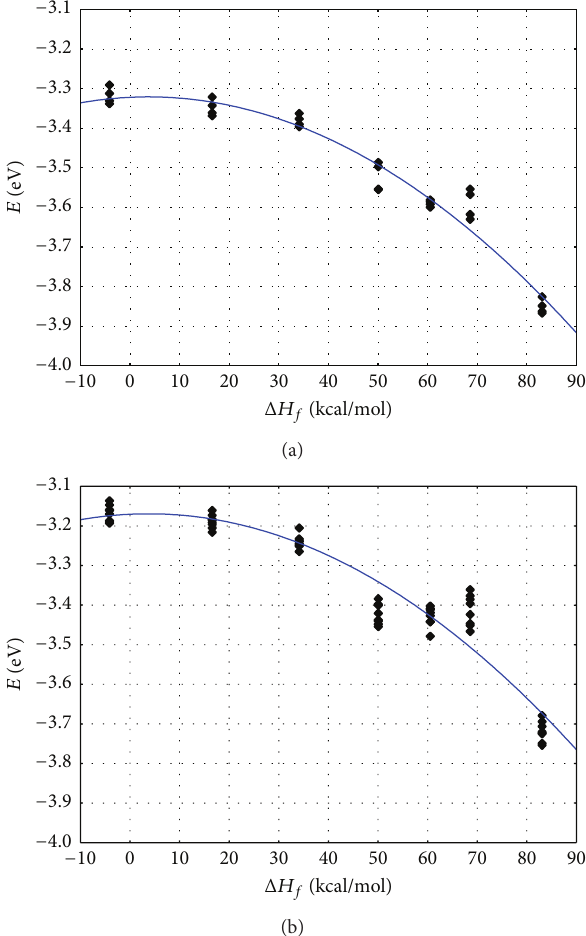
Figure 2: Relationships between Δ𝐻 𝑓 (ChemoSophia Elastic Model) and 𝐸 (DFT B3LYP 6-311G(d,p)) (a) for [1,2,5]oxadiazolo[3, 4- c ]pyridine; (b) for [1,2,5]thiadiazolo[3,4- c ]pyridine and [1,2,5]sel- enadiazolo[3,4- c